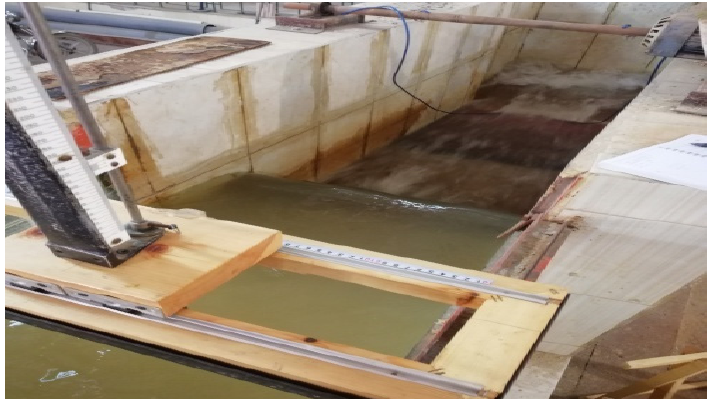
Figure 2. General view of the calibrated weir.